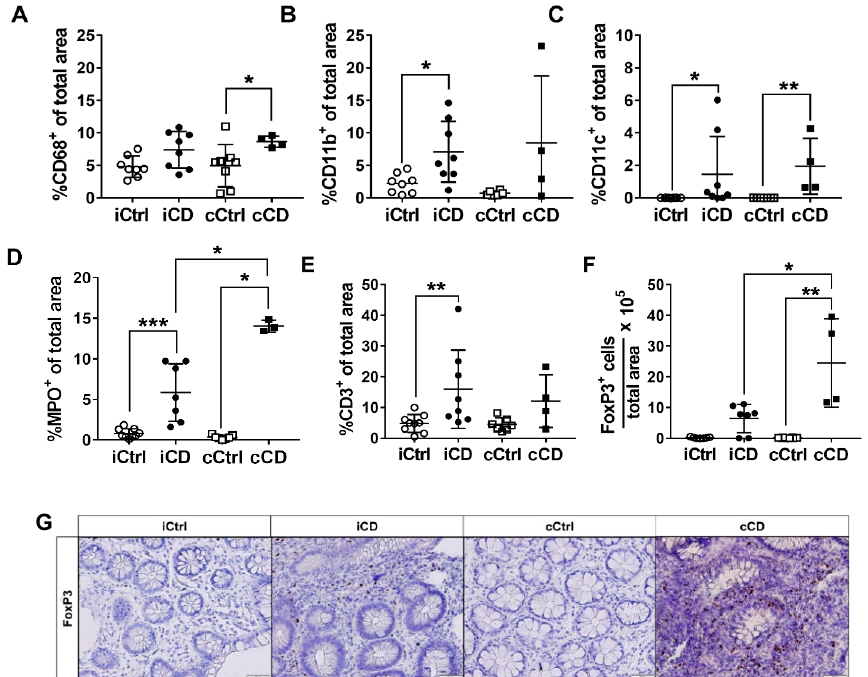
Figure 1. Enhanced immune cell infiltration in intestinal tissue of patients with active CD. Differential quantitative and localization-dependent evaluation of the area percentages of ( A ) CD68 + , ( B ) CD11b + , ( C ) CD11c + , ( D ) MPO + , ( E ) CD3 + and ( F ) FoxP3 + . ( G ) Analysis of FoxP3